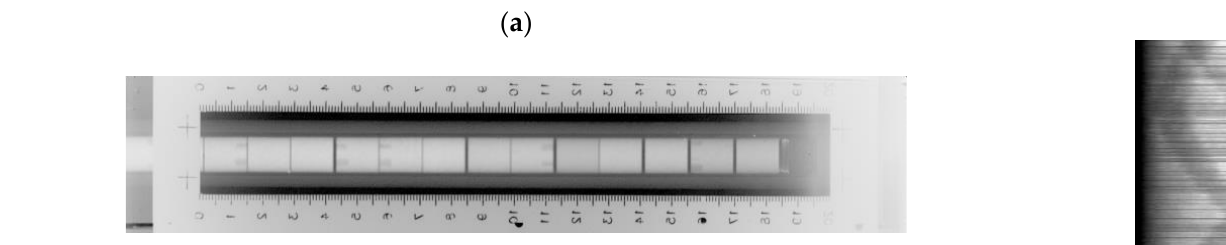
Figure 10. Reconstructed results obtained by using the different algorithms with the display windows set to [0, 1]. ( a ) Reconstructed results obtained by using FBP algorithm and 180 views; ( b ) reconstructed results obtained by using FBP algorithm and 60 views; ( c ) reconstructed results obtained by using SIRT algorithm and 60 views; ( d ) reconstructed results obtained by using SIRT-TV algorithm and 60 views; ( e ) reconstructed results obtained by using SIRT-WTDM algorithm and 60 views; ( f ) reconstructed results obtained by using SIRT-MWTDM algorithm and 60 views.